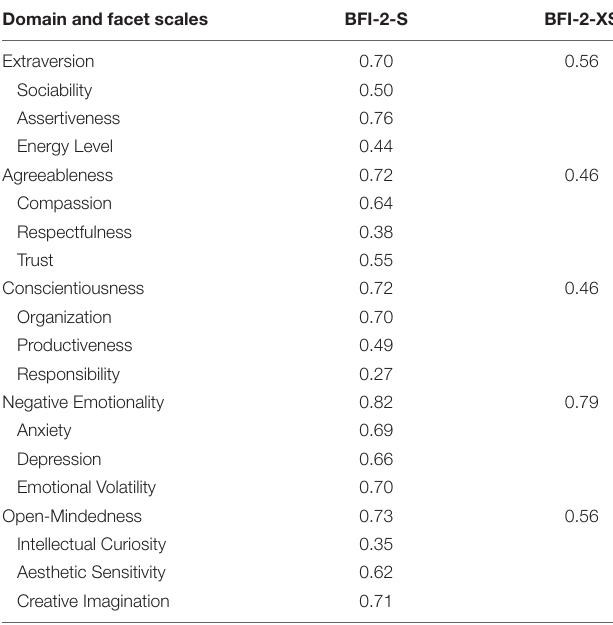
TABLE 10 | Cronbach’s alpha for scores from BFI-2-S and